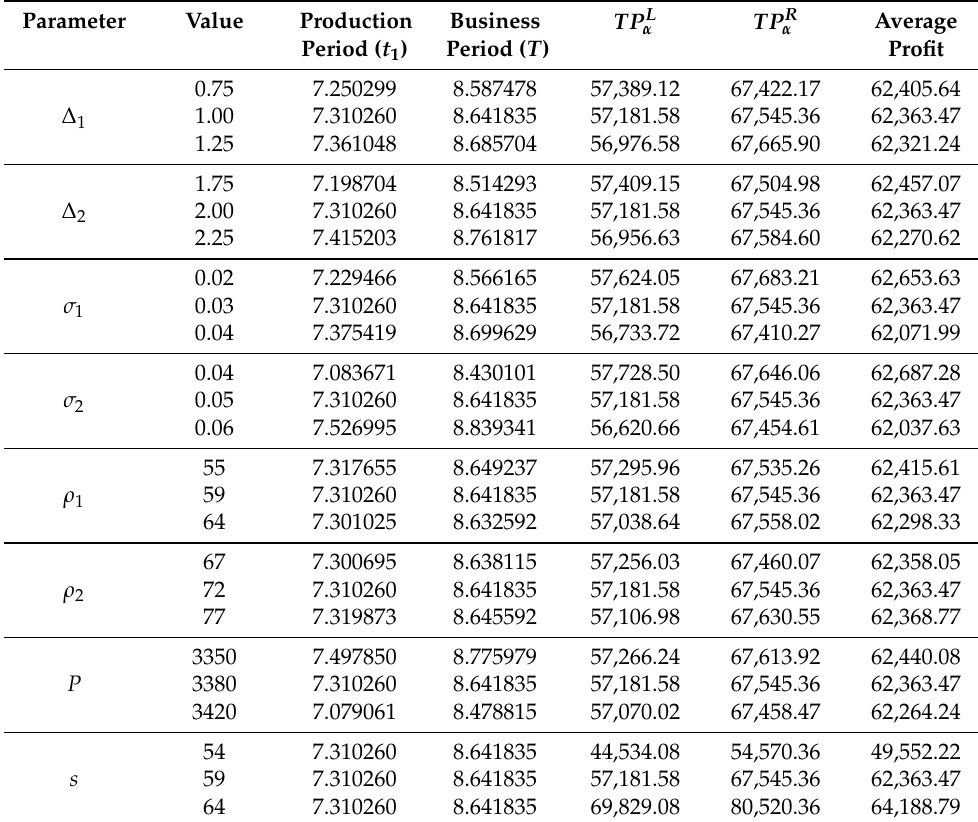
Table 16. Sensitivity analysis on Example 1 with respect to ∆ 1 , ∆ 2 , σ 1 , σ 2 , ρ 1 , ρ 2 , P and S